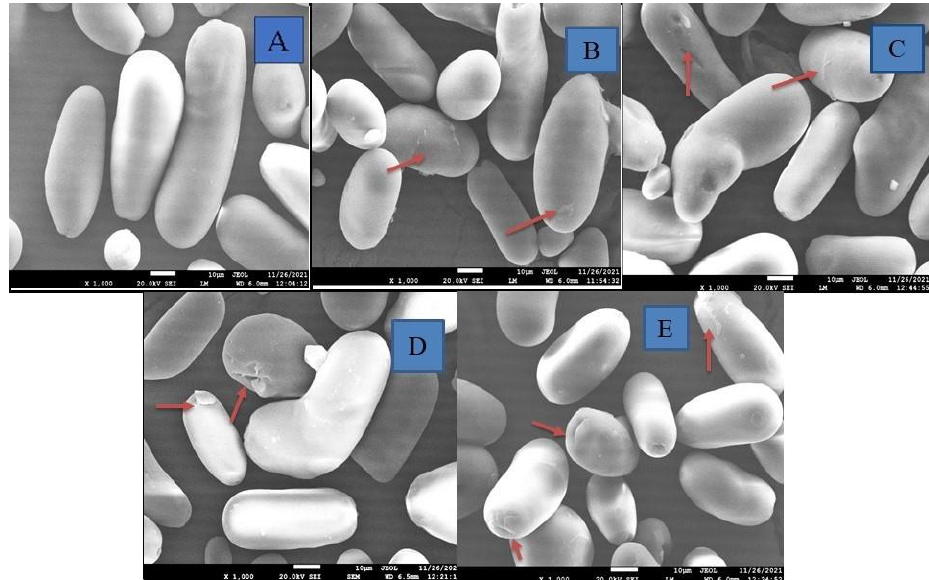
Figure 2. Morphological properties of native and modified lotus rhizome starches. ( A )—Native; ( B )—Microwaved (MI); ( C )—Irradiated (IR); ( D )—Microwaved–Irradiated (MI-IR); ( E )—Irradiated– Microwaved